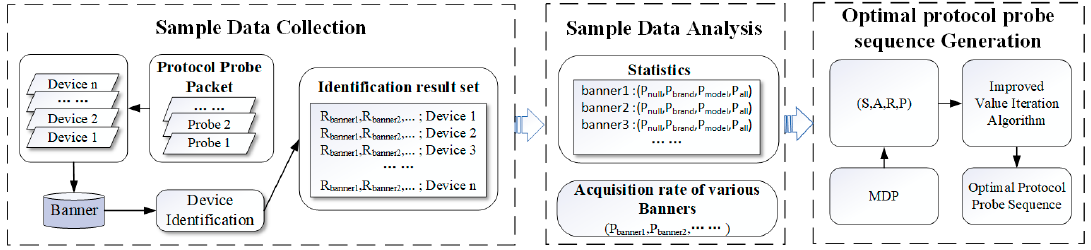
Figure 2. Time-efficient multi-protocol probe framework. Figure 2. Time-e ffi cient multi-protocol probe